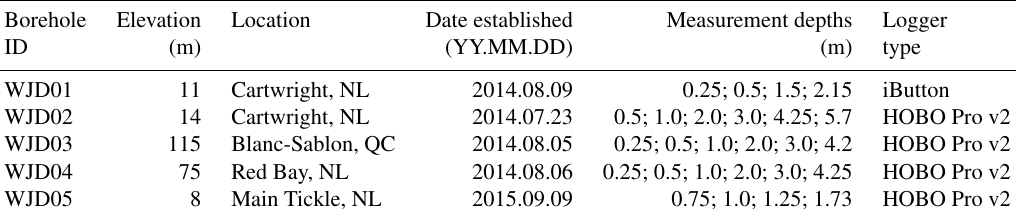
Table 2. Site information for temperature monitoring boreholes. Borehole Elevation Location Date